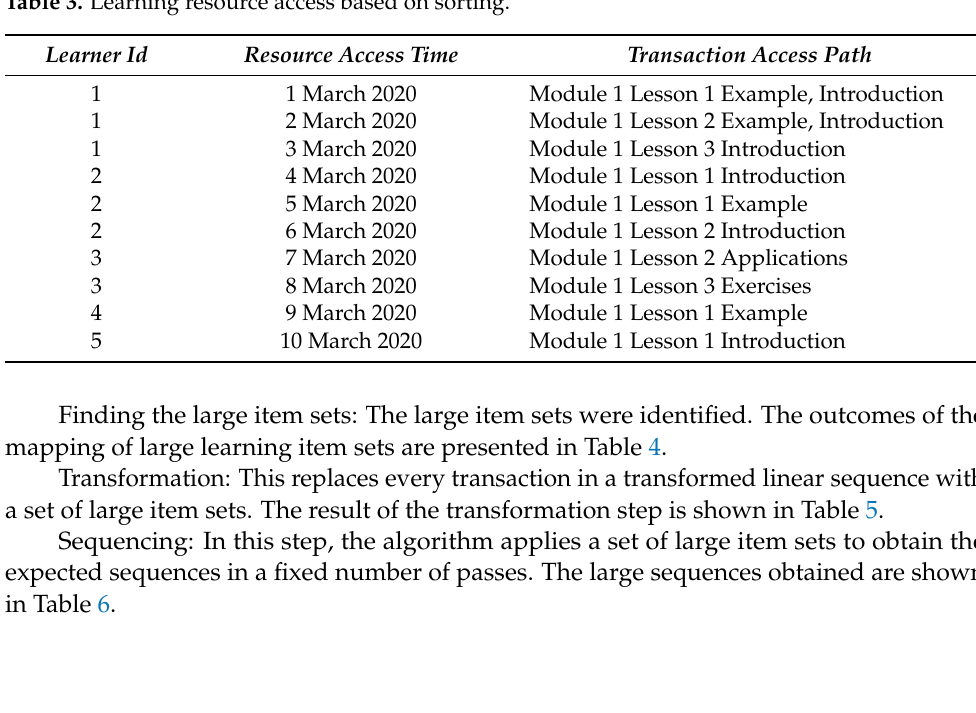
Table 3. Learning resource access based on